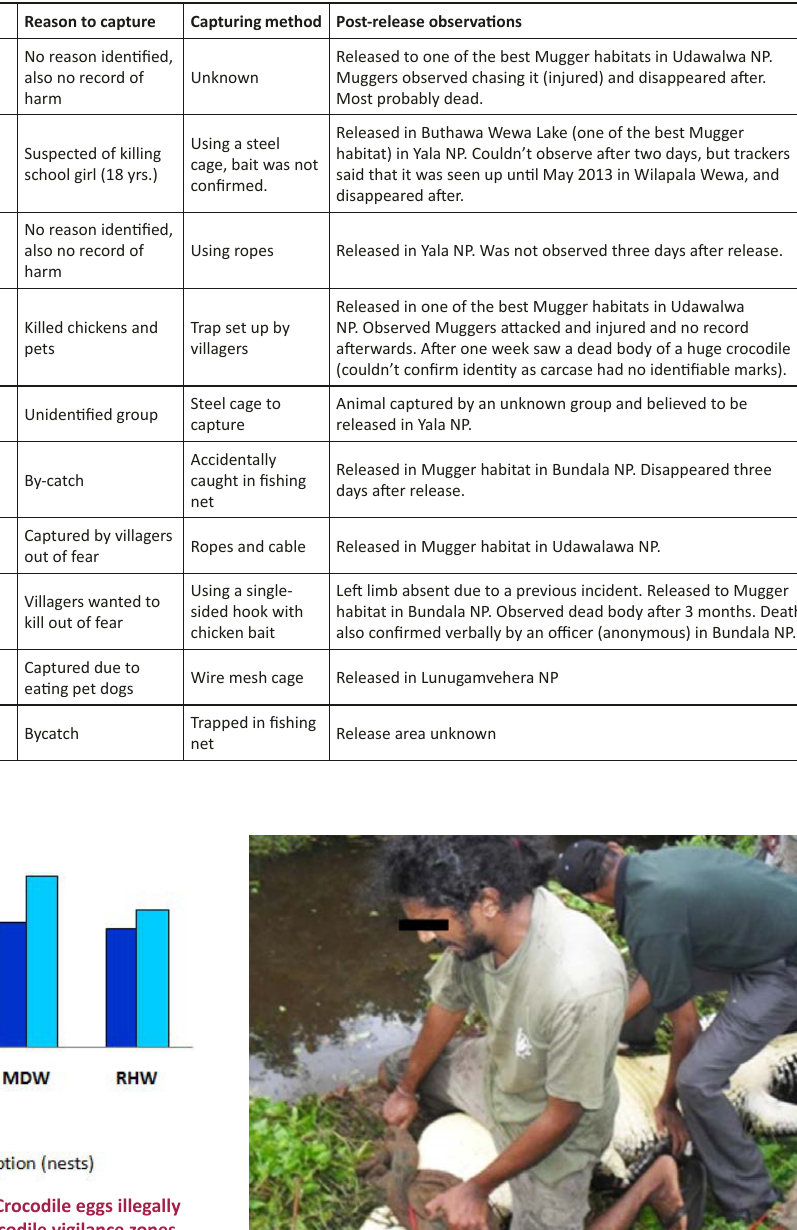
Table 2. Translocations of Saltwater Crocodiles in 2008-2013, for which data were recorded and/or were available (CVZ, crocodile vigilance zone - see text for full names; TL, approximate total length of crocodiles; NP, national park; RB, river